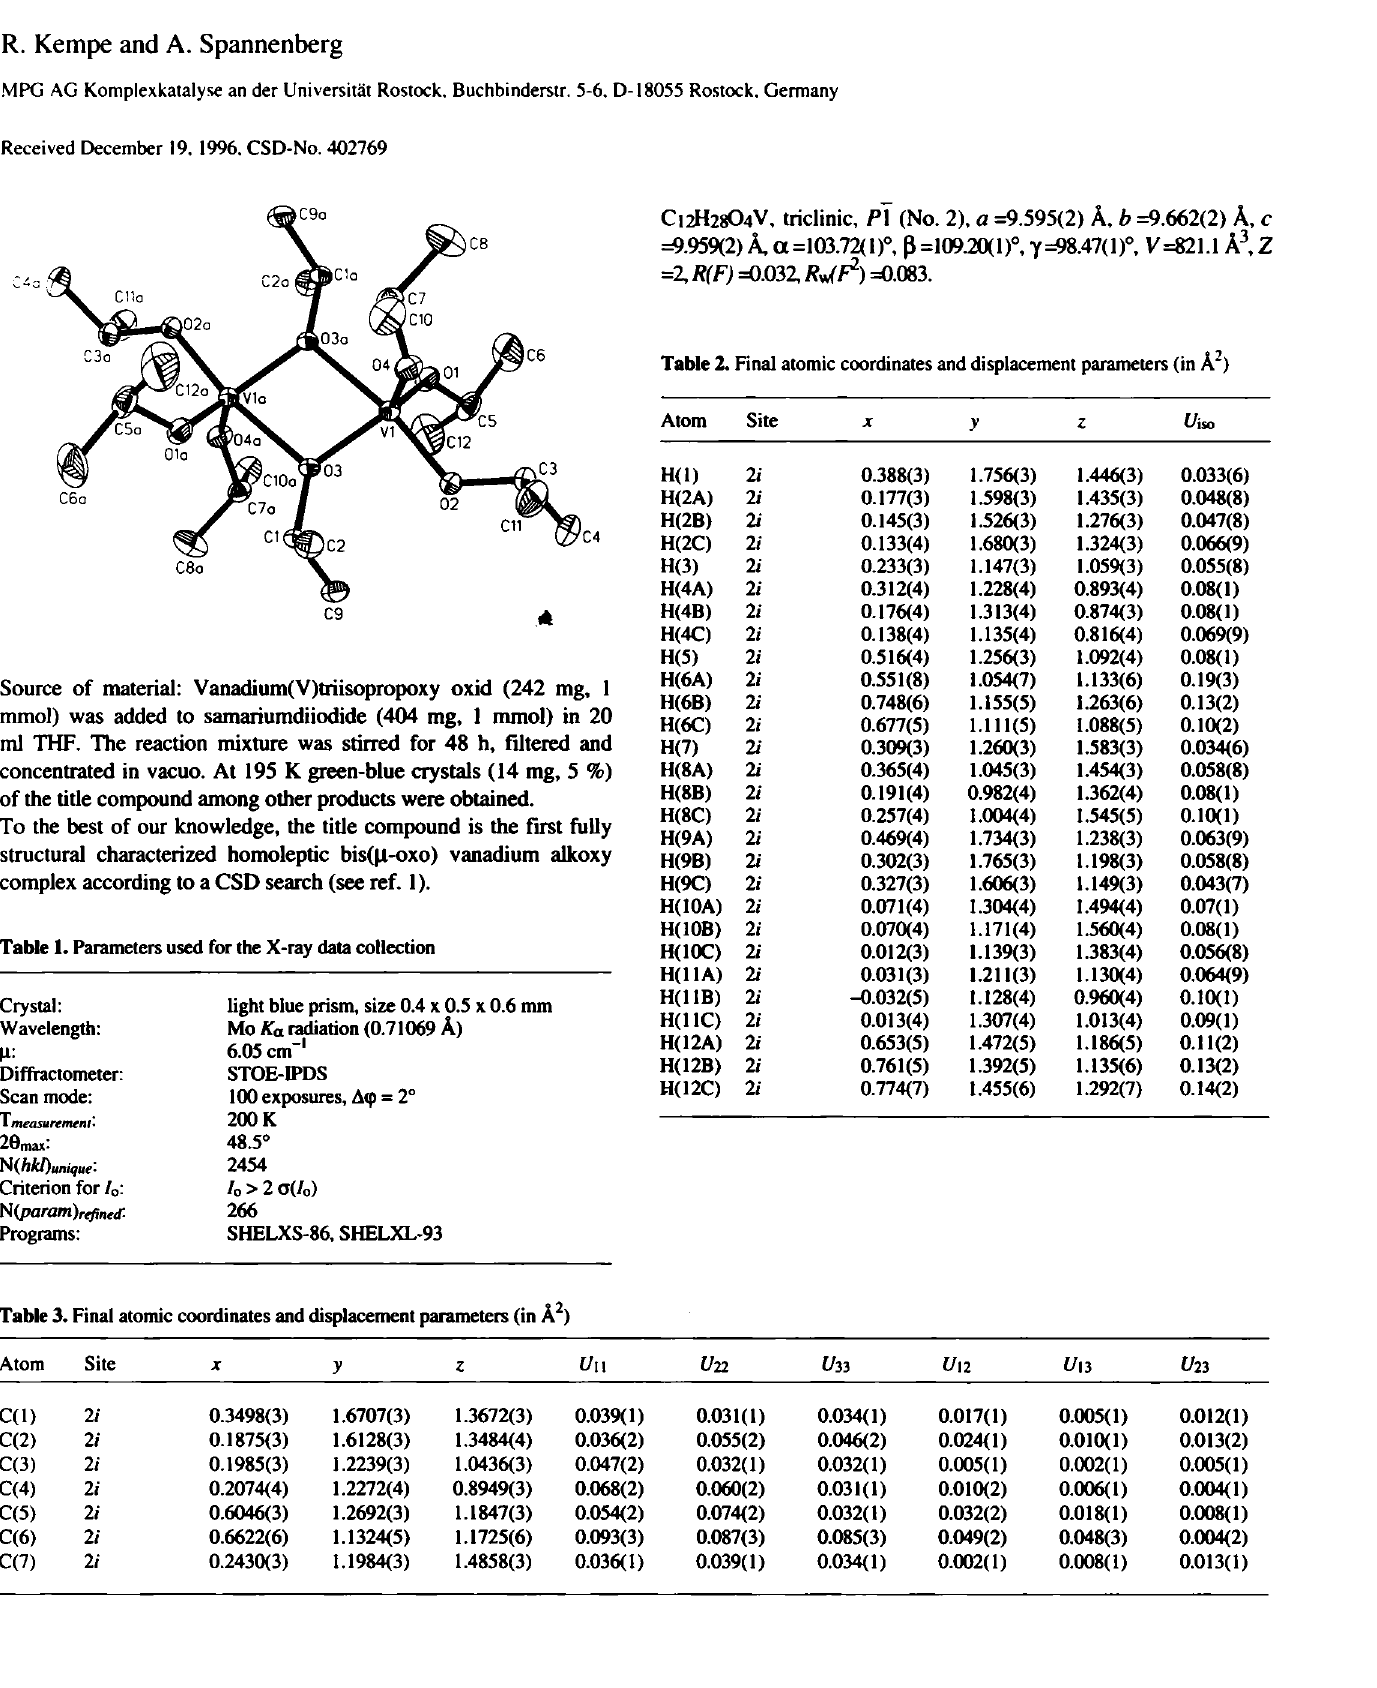
Table 3. Final atomic coordinates and displacement parameters (in Â 2